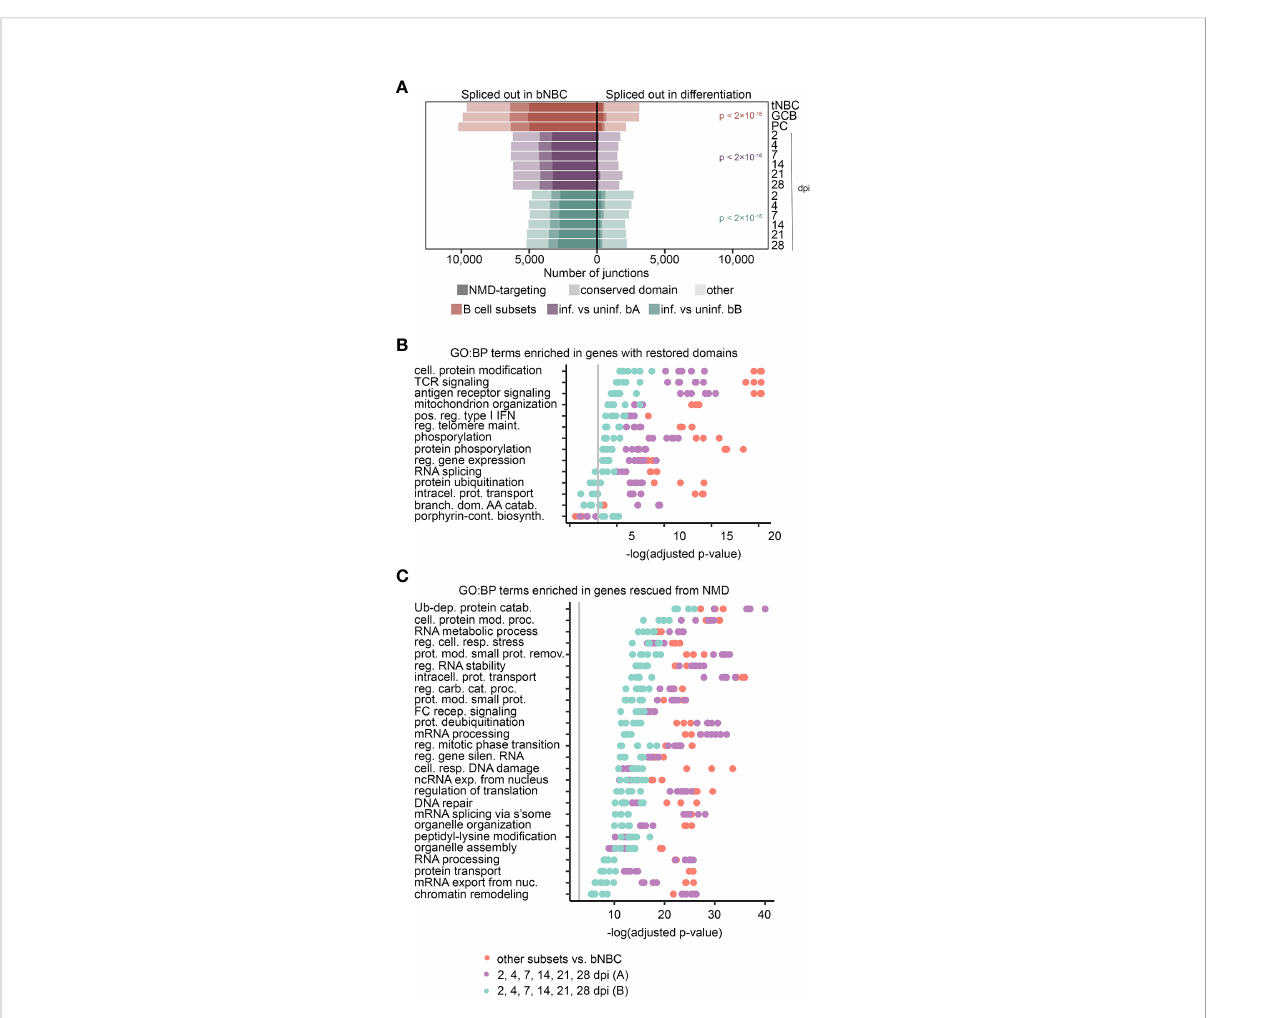
FIGURE 4 Exon inclusion restores domains and evades NMD in important pathways. (A) Exons with altered usage (rMATS FDR < 0.05) in lymphoid (tonsil) NBCs (tNBC), GC B cells (GCB) and PCs compared to blood NBCs (red) or EBV infection of blood B cells (purple = infection timecourse A, green = infection timecourse B). Exons that encode conserved protein domains are lightly shaded, exons that induce NMD targeting when skipped are heavily shaded. P-values for the proportion of damaging exon skipping events (NMD-targeting or domain-skipping) in blood NBCs compared to differentiating or EBV-infected cells were calculated using a pairwise comparison of proportions test with Bonferroni correction. (B) GO Biological Process term enrichment in genes with conserved protein domains restored by exon inclusion in differentiating or EBV- infected cells. The top 5 terms with lowest adjusted p-value for each experiment/timepoint are shown. (C) GO Biological Process term enrichment in genes with NMD targeting reduced by exon inclusion in differentiated or EBV-infected cells. The top 10 terms with lowest adjusted p-value for each experiment/timepoint are shown. For panels (B, C) , redundant terms are not displayed, complete enrichment information is available in Supplemental Table 7. Vertical grey line indicates adjusted p-value = 0.05. Adjusted p-values calculated by Enrichr using Fisher ’ s exact test with Benjamini-Hochberg correction. For all panels B cell subset comparisons include 3 subsets (tonsil NBCs, GC B cells, and PCs) compared to blood NBCs. Each B cell subset includes 3 replicates. Blood infection timecourse A (purple) includes 6 timepoint comparisons with 3 replicates each, Blood infection timecourse B (green) includes 6 timepoint comparisons with 1 replicate